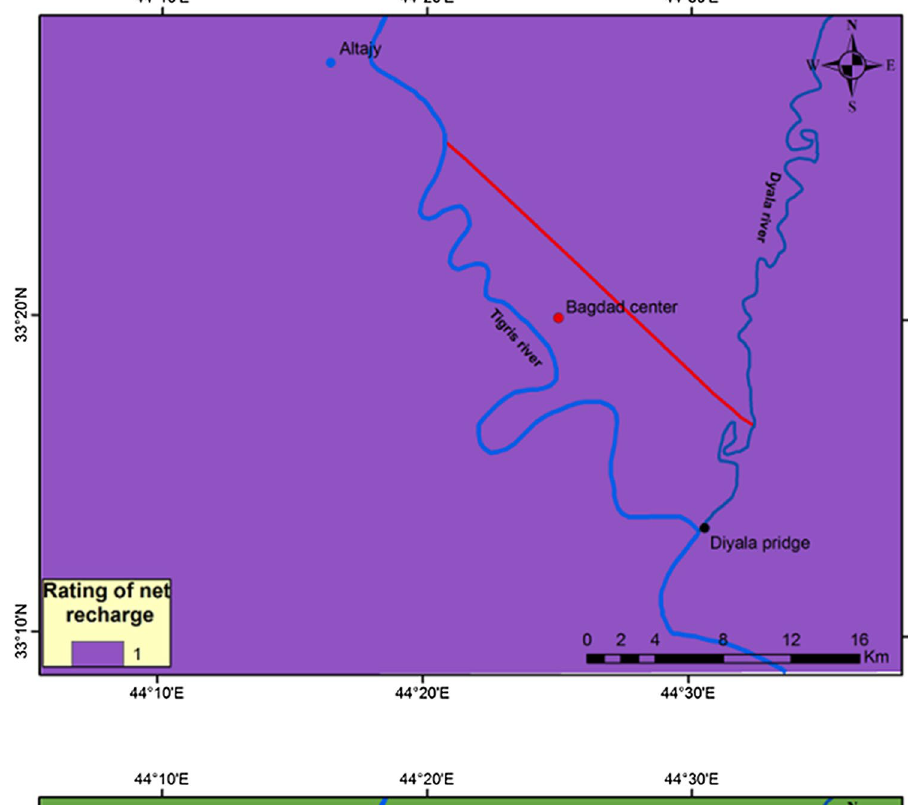
Fig. 7 Rating of aquifer media map of the study